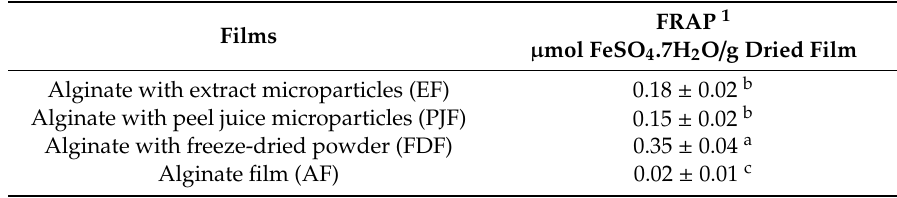
Table 1. Antioxidant activity of alginate films with microparticles and pineapple peel powder.